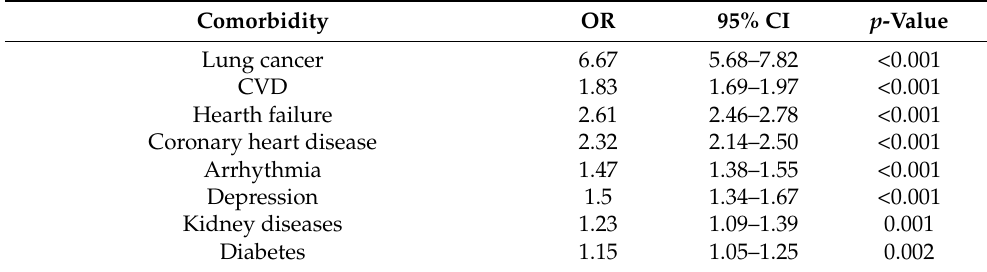
Table 3. ORs from multivariate logistic regression analysis of COPD